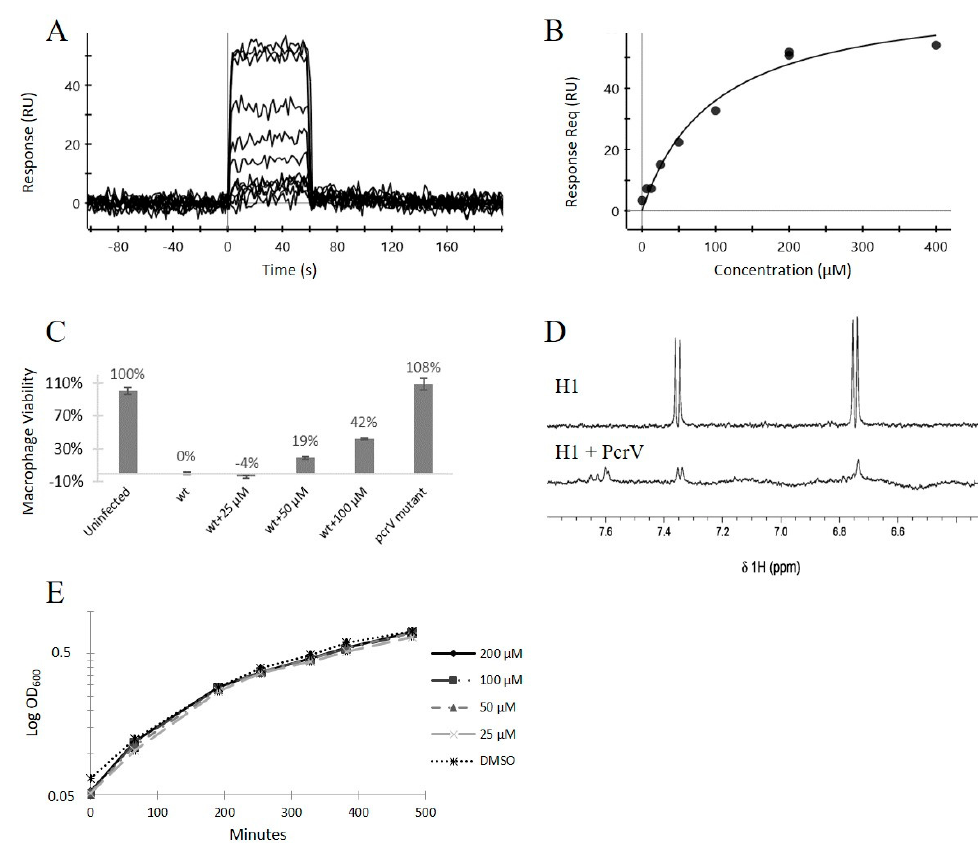
Figure 3. ( A ) Surface plasmon resonance data for compound H1 binding to PcrV at 400, 200 (duplicate), 100, 50, 25, 12.5, 6.25, and 0 µM. ( B ) Equilibrium analysis of compound H1 from binding levels at 45-55 s in A : K D was determined to be 98.3 µM. R max was 71.3 RU, and Chi 2 was 10.0 RU. ( C ) Infection assay with dose-response analysis of compound H1 that protects macrophages from T3SS-mediated P. aeruginosa toxicity (wt): uninfected cells and infection with a pcrV mutant were used as controls, and standard deviation was calculated by Gaussian approximation. ( D ) 1 H NMR relaxation-edited binding experiment showing the aromatic region for compound H1 at 100 µM with (bottom trace) and without 10 µM PcrV (upper trace): equilibrium analysis was performed in the ProteOn Manager software TM (Bio-Rad Laboratories Inc., Hercules, CA, USA). ( E ) Bacterial growth assay where P. aeruginosa was grown in the presence of compound H1 at 200, 100, 50, and 25 µM and OD600 was measured regularly for 8 h: each value represents the mean value of a triplicate; to the control wells, 1% DMSO was added (DMSO). The panels show one representative experiment.